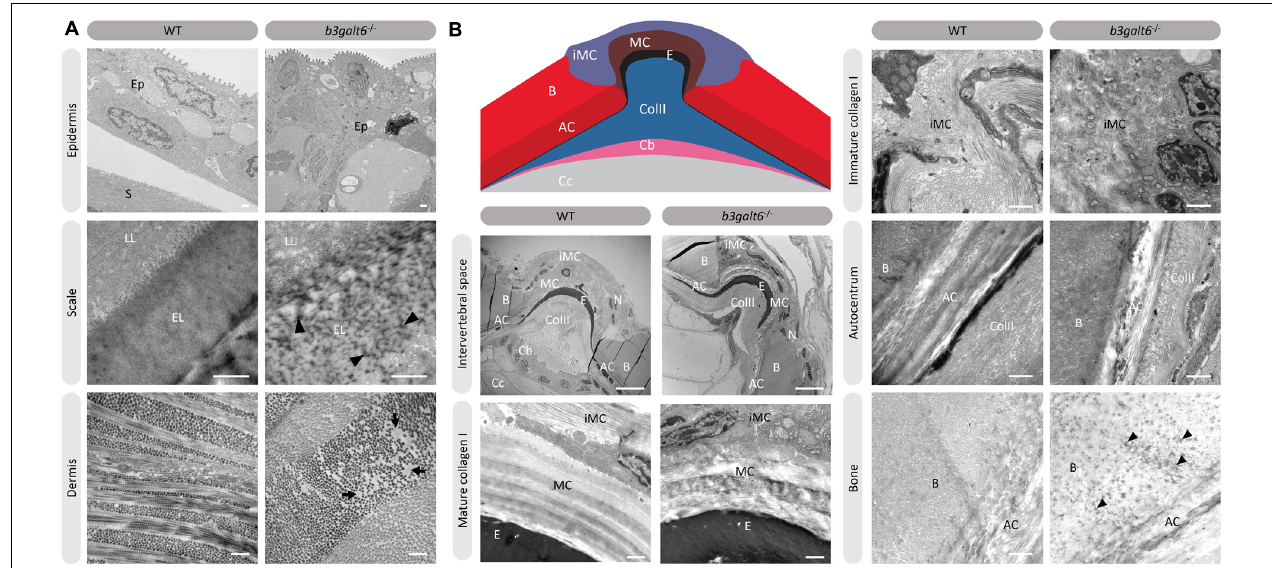
FIGURE 7 | Collagen fibrillar architecture in 5 months old adult zebrafish. (A) Skin from 5 months old WT and b3galt6 − / − adult zebrafish. The epidermis (Ep), the outer layer of the skin covering the scales (S) of zebrafish, appears thicker in b3galt6 − / − zebrafish compared to the epidermis of WT zebrafish. A mature zebrafish scale consists of several layers. The limiting layer of the scale (LL) is rich in fine granules that in some areas are linearly arranged, forming dense layers. This matrix contrasts with that of the external layer(s) (EL) below. Structures resembling extrafibrillar crystals (arrowhead) are noted in the external layer of the mutant scale, which are rare in WT zebrafish sections. Upon investigation of the dermis of b3galt6 − / − mutants, increased interfibrillar spaces are noted (arrows), which are absent in the dermis of WT adults. Scale bars = 500 nm. (B) Schematic representation and TEM images of the zebrafish intervertebral space. Schematic representation of the zebrafish intervertebral space. AC, autocentrum; B, bone; Cb, chordoblasts; Cc, chordocytes; ColII, type II collagen; E, elastin; iMC, immature collagen type I layer; MC, mature collagen type I layer. Starting from the central body axis, several recognizable structures are present in the intervertebral space along a proximo-distal axis: (i) notochord tissue consisting of chordocytes and chordoblasts, (ii) the notochord sheath consisting of a type II collagen layer and an external elastic membrane, (iii) and a connective tissue ligament consistent of a mature and an immature type I collagen layer. The mature type I collagen layer is organized in a typical plywood-like pattern and is continuous with the inner layer of the vertebral bone, i.e., the autocentrum, which also shows a plywood-like organization. The immature type I collagen layers consist of loose collagen fibers connecting the outer layer of vertebral bones. Notice the higher number of nuclei (N) in the b3galt6 − / − zebrafish at the intervertebral space. Mature collagen (MC) displays a typical plywood-like organization, in WT zebrafish but not in comparable regions for b3galt6 − / − mutant zebrafish. Cross section and longitudinal type I collagen regions are less clearly demarcated and smaller in immature collagen (iMC) from b3galt6 − / − zebrafish compared to WT siblings. It is more difficult to pinpoint the different layers of the autocentrum (AC) in the KO compared to WT zebrafish. Bone (B) from the b3galt6 − / − zebrafish shows electron dense structures (arrowhead). Scale bars = 10 µ m for the intervertebral space and 1 µ m for the other